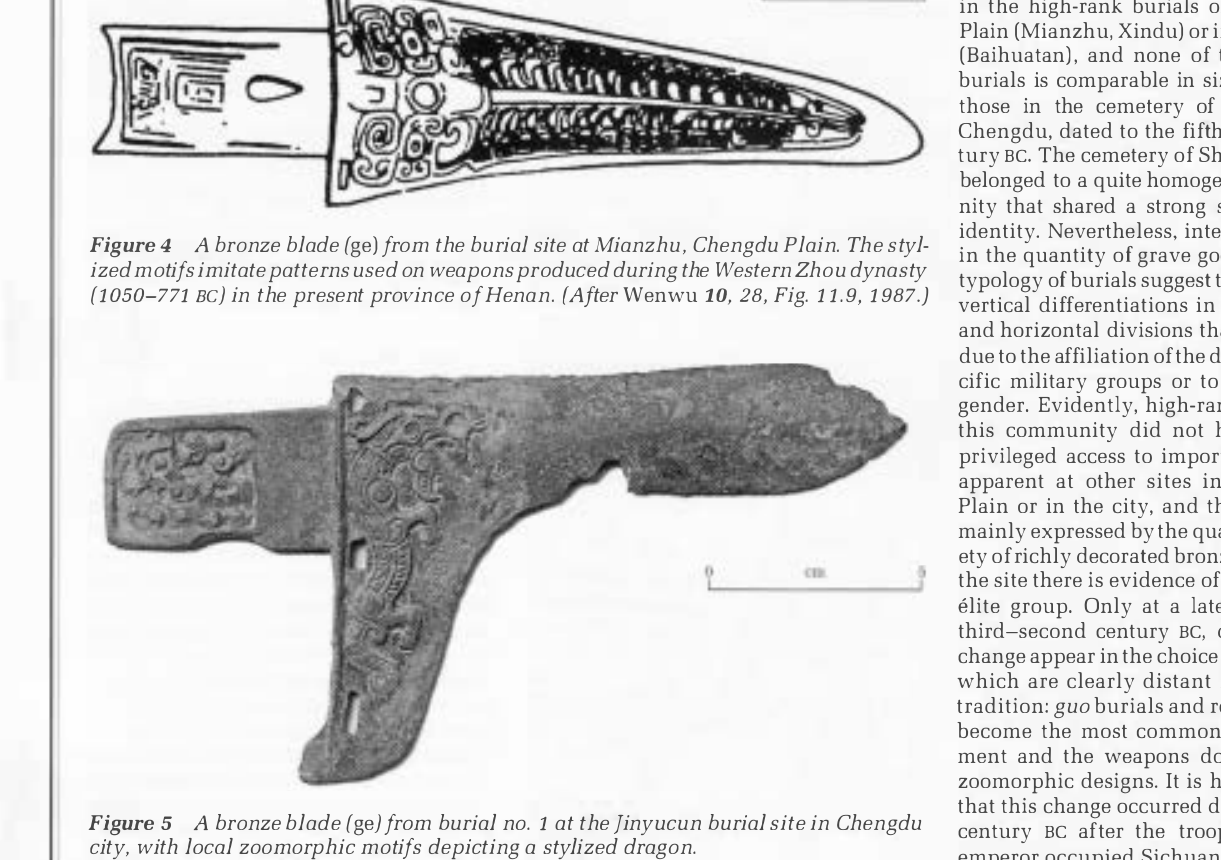
Figure 5 A bronze blade (ge) from burial no. 1 at the Jinyucun burial site in Chengdu city, with local zoomorphic motifs depicting a stylized dragon. similar weapons of the Western Zhou dynasty (1050-771 BC) fromHenan (Fig.